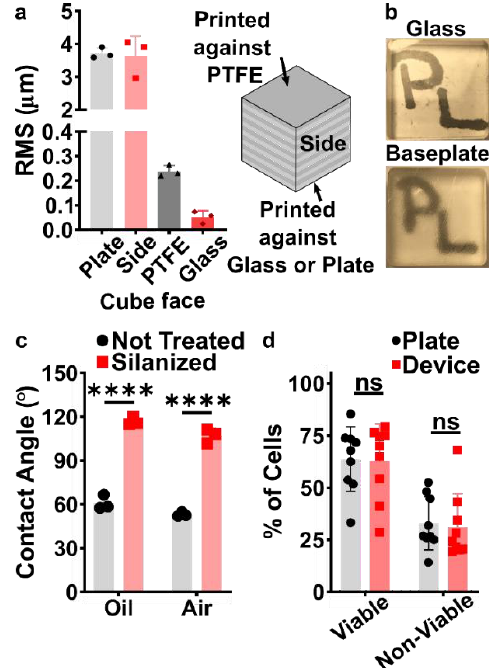
Figure 2. Identification of conditions to ensure suitable surface roughness, optical transparency, surface chemistry, and biocompatibility of the BV-007A printed parts. ( a ) The root mean square (rms) height of surfaces printed against a micro-milled aluminum baseplate, the side of the print, the final print layer closest to the PTFE vat bottom, or printed against a glass slide ( n = 3, mean ± Std Dev). ( b ) Photos of clear resin parts printed on glass or on the micro-milled aluminum baseplate, showing the optical clarity of the former. ( c ) Three-phase contact angles of a droplet of phosphate buffered saline on a printed part in fluorinated oil or in air, measured before (not treated) and after fluorosilanization of the part. Two-way ANOVA with Tukey’s multiple comparison test, n = 3, mean ± Std Dev, **** p < 0.0001. ( d ) The percent of viable (Calcein high , 7-AAD low ) and non-viable (7-AAD high ) cells after 15 min exposure to a 3D printed part or a plate control ( n = 9, mean ± Std Dev). Two-way ANOVA with Tukey’s multiple comparison test; ns indicates p >